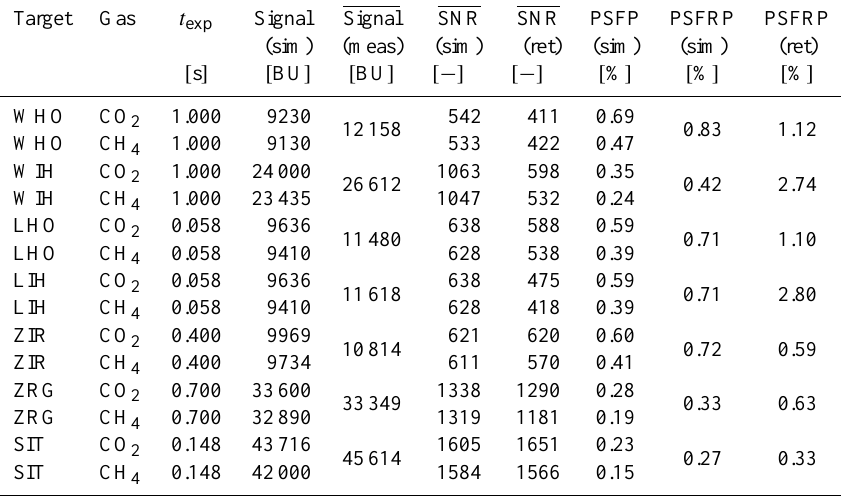
Table 3. Simulated and measured MAMAP SWIR single readout detector performance for different reference targets including on-ground and in-flight measurements. The table includes the exposure time t exp (column 3), the simulated and measured signal in [ BU ] (column 4 and 5), the simulated and retrieved SNR (column 6 and 7), the simulated profile scaling factor precision (PSFP) for each gas (column 8) and the simulated and (from measurements) mean retrieved profile scaling factor ratio precision (PSFRP) calculated from the CH 4 /CO 2 PSF ratios (column 9 and 10).